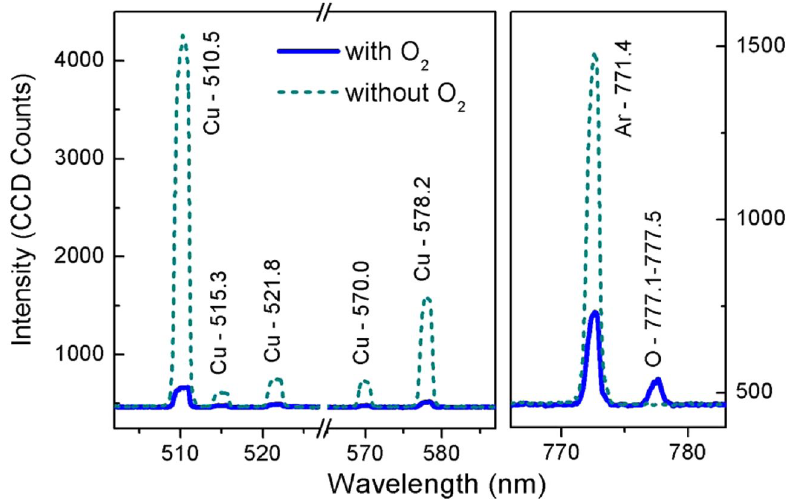
Figure 8. Emission spectra of the magnetron plasma showing the intensity decrease of Cu and Ar lines, and the appearance of excited atomic oxygen, when O 2 was added through gas